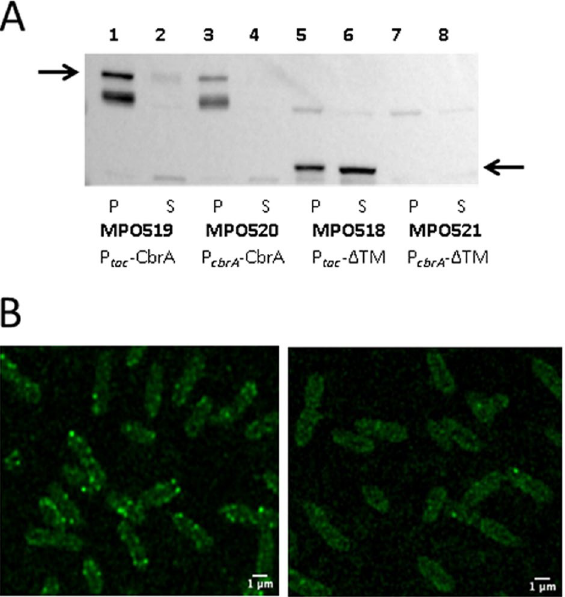
Figure 9. CbrA and Δ TM-CbrA detection by Western blot and confocal microscopy. ( A ) Western blot of soluble and membrane fractions of strains MPO519 (P tac -CbrA), MPO520 (P cbrA -CbrA), MPO518 (P tac - Δ TM) and MPO521 (P cbrA - Δ TM) grown in a minimal medium with succinate as carbon source. 10 μ g of total protein from the unsoluble fractions (lanes 1, 3, 5 and 7) and supernatants (lanes 2, 4, 6 and 8) were loaded onto SDS- PAGE gels. Unsoluble fractions were concentrated 10-fold in order to normalise the amount of total protein loaded in the gel. The black arrows indicate the size corresponding the CbrA- and Δ TM-GFP fusion proteins (136 and 80 kDa, respectively). ( B ) Fluorescence visualisation of strains MPO520 (WT CbrA) (left) and MPO521 ( Δ TM-CbrA) (right) with a confocal laser scanning microscope Zeiss LSM 880 equipped with an Airyscan detection unit (63X). Scale bar is indicated in the right. Both pictures obtained from the LCSM were processed with the same